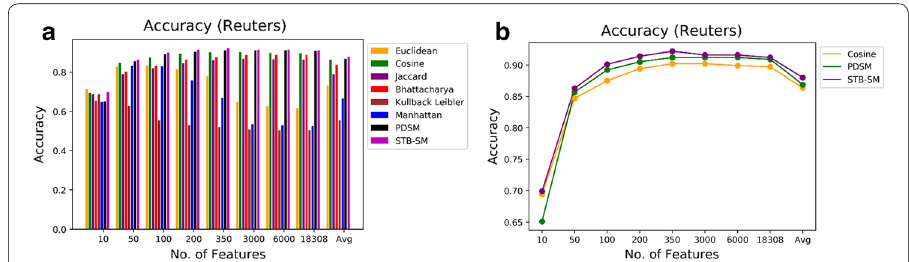
Fig. 1 a Accuracy over all Measures on all NF values– Average results (K over competitive measures on all NF values– Average results (K